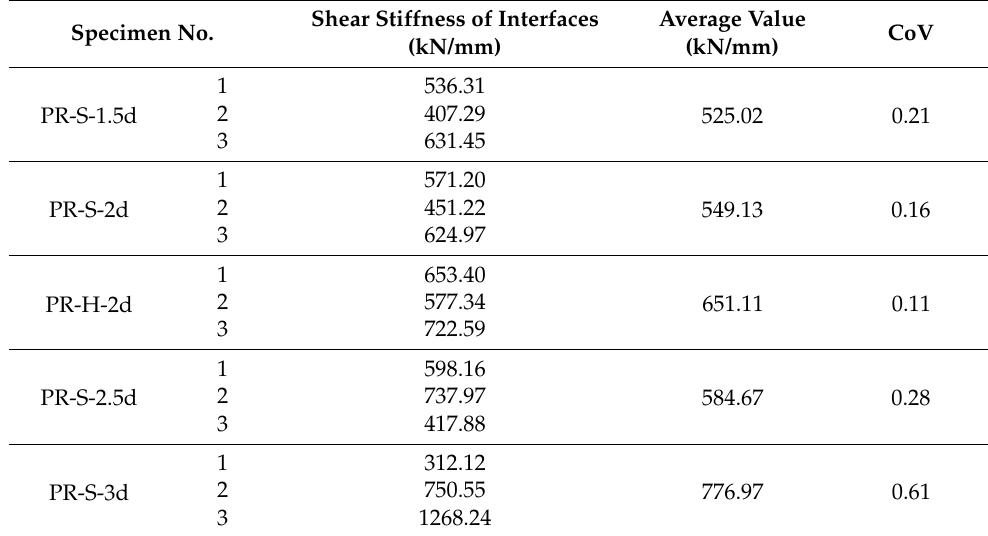
Table 6. Shear stiffness of UHPC-NC interfaces. Specimen